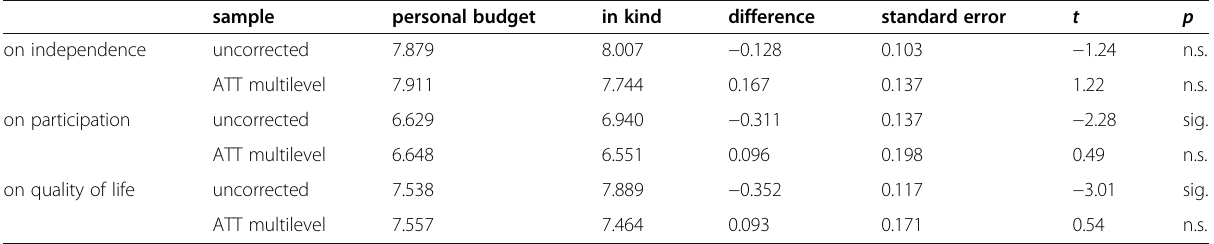
Table 2 Estimated values for the dependent variables (on a scale from 1 to 10) independence, participation and quality of life for respondents who have chosen a PB or help in kind ( n = 446)